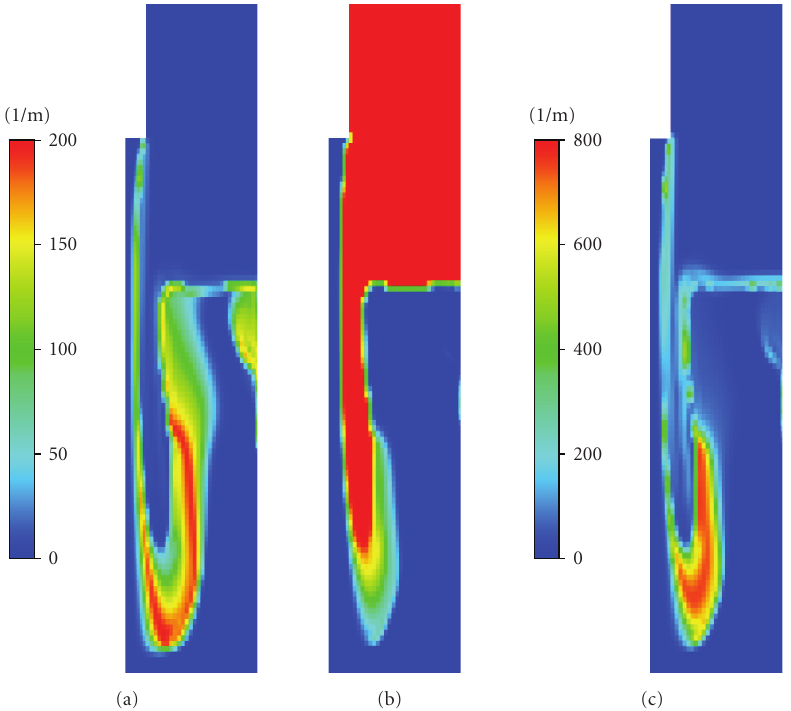
Figure 16: (a) Total area density a . (b) Total drag coe ffi cient C D . (c) Product a C D .